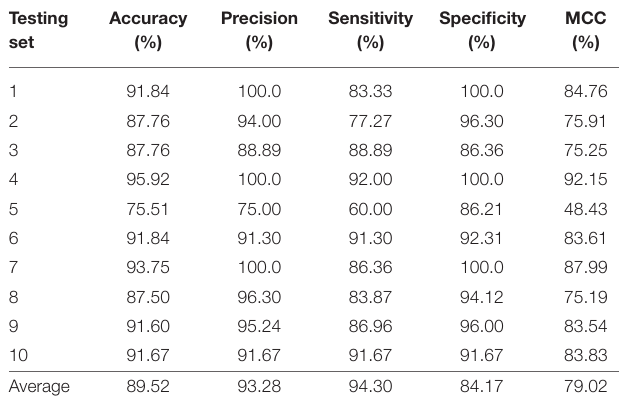
TABLE 2 | Ten-fold cross-validation results on dataset RPI369. Testing set